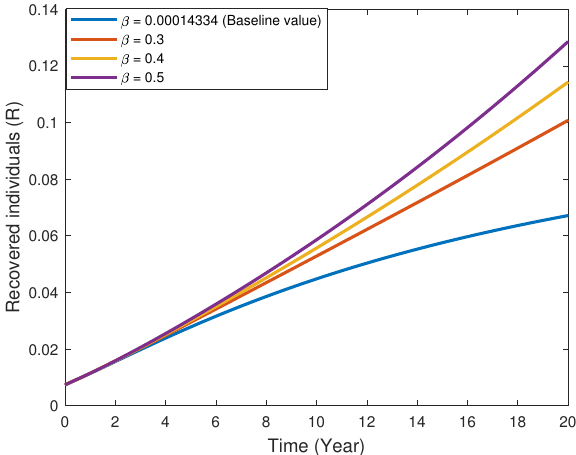
Figure 13. Behavior of R class for different β values.